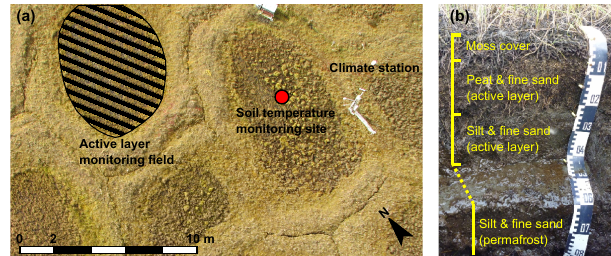
Figure 3. Images from the Samoylov Island site. (a) Aerial view showing monitoring stations. (b) Typical soil profile showing moss layer, organic layer and mineral